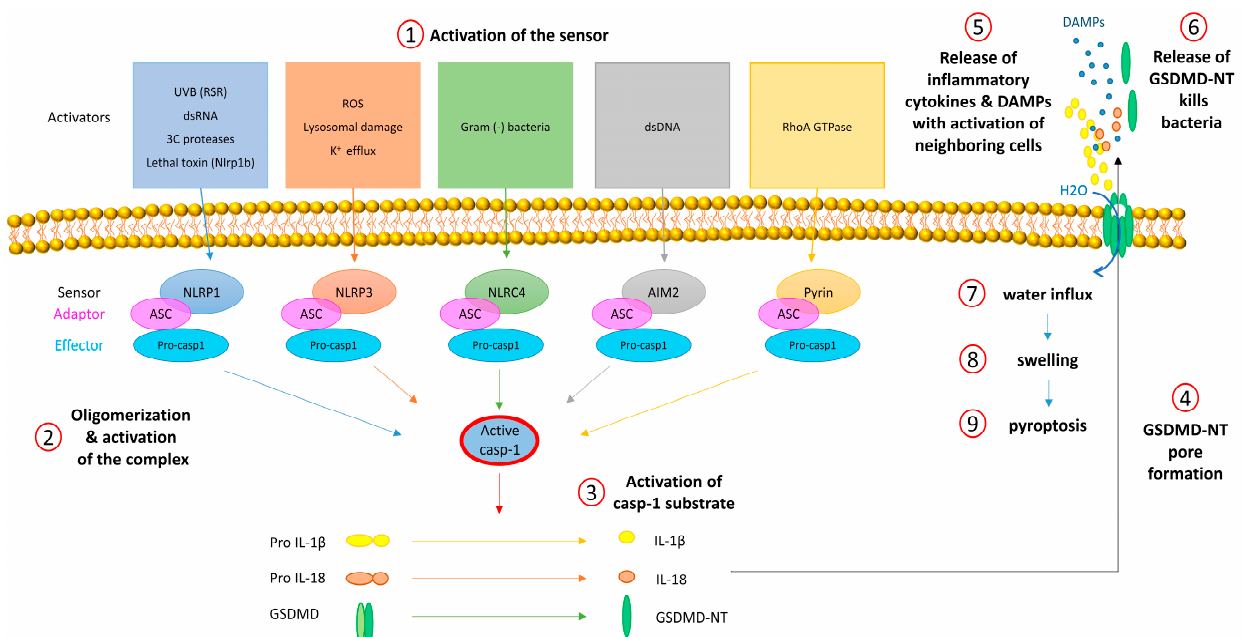
Figure 1. Activation of inflammasomes and downstream mechanisms. (1) Each inflammasome sensor is activated by specific stressors. (2) Activation is associated with oligomerization of the sensor and of the adaptor protein ASC (ASC speck formation) followed by proteolytic self-activation of pro-caspase-1. (3) Active caspase-1 cleaves and thereby activates the pro-inflammatory cytokines proIL-1 β and -18 and GSDMD. (4) GSDM-NT oligomerizes and forms pores in the cell membrane. (5) Via GSDMD pores, IL-1 β , IL-18, and other molecules are released and induce inflammation by activation of immune and other neighboring cells. (6) Released GSDMD-NT inserts into the membrane of pathogens and kills them. (7) Through GSDMD-NT pores, water enters the cell (8) causing swelling and (9) rupture of the cell. This lytic type of cell death is termed pyroptosis and supports inflammation.